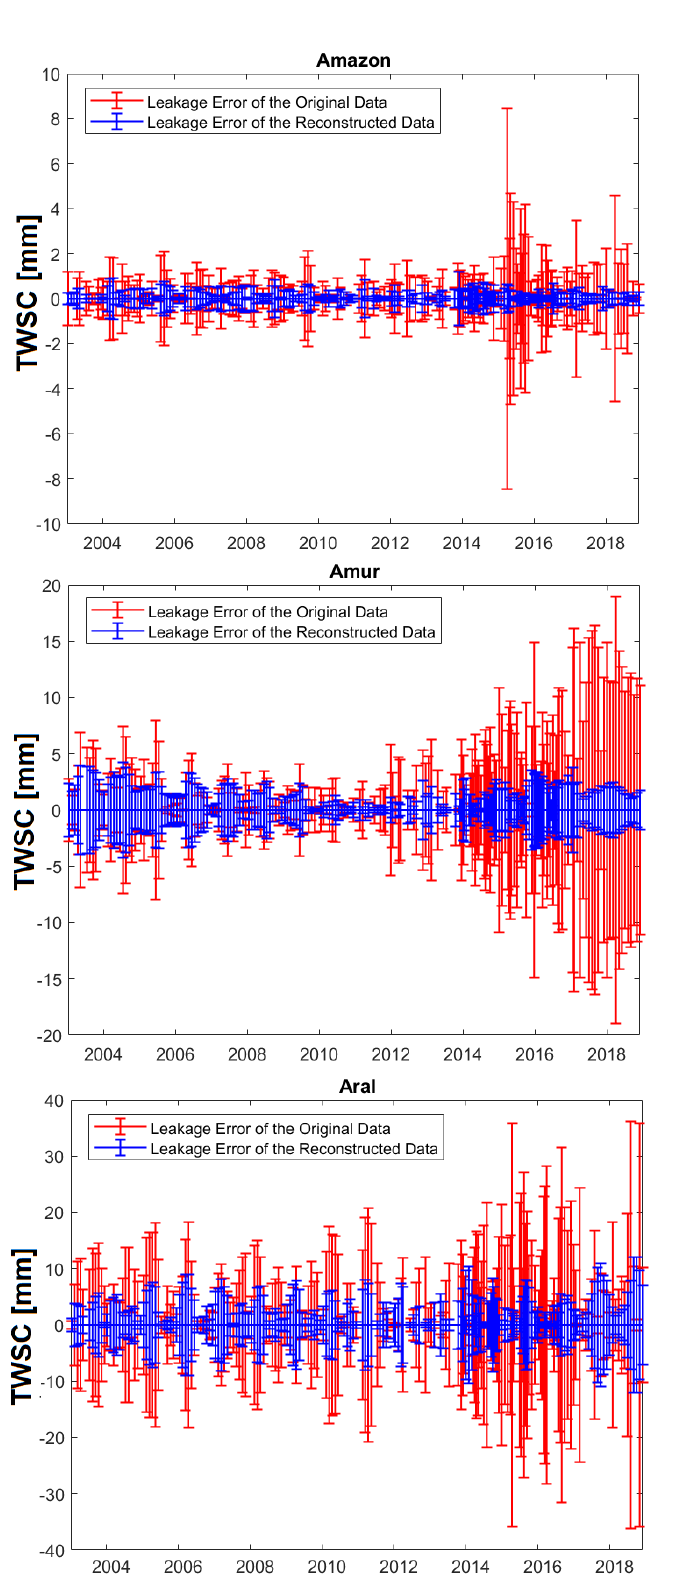
Figure A4. Estimated leakage error for the tree river basins of Amazon ( top ), Amur ( middle ), and Aral ( bottom ) river